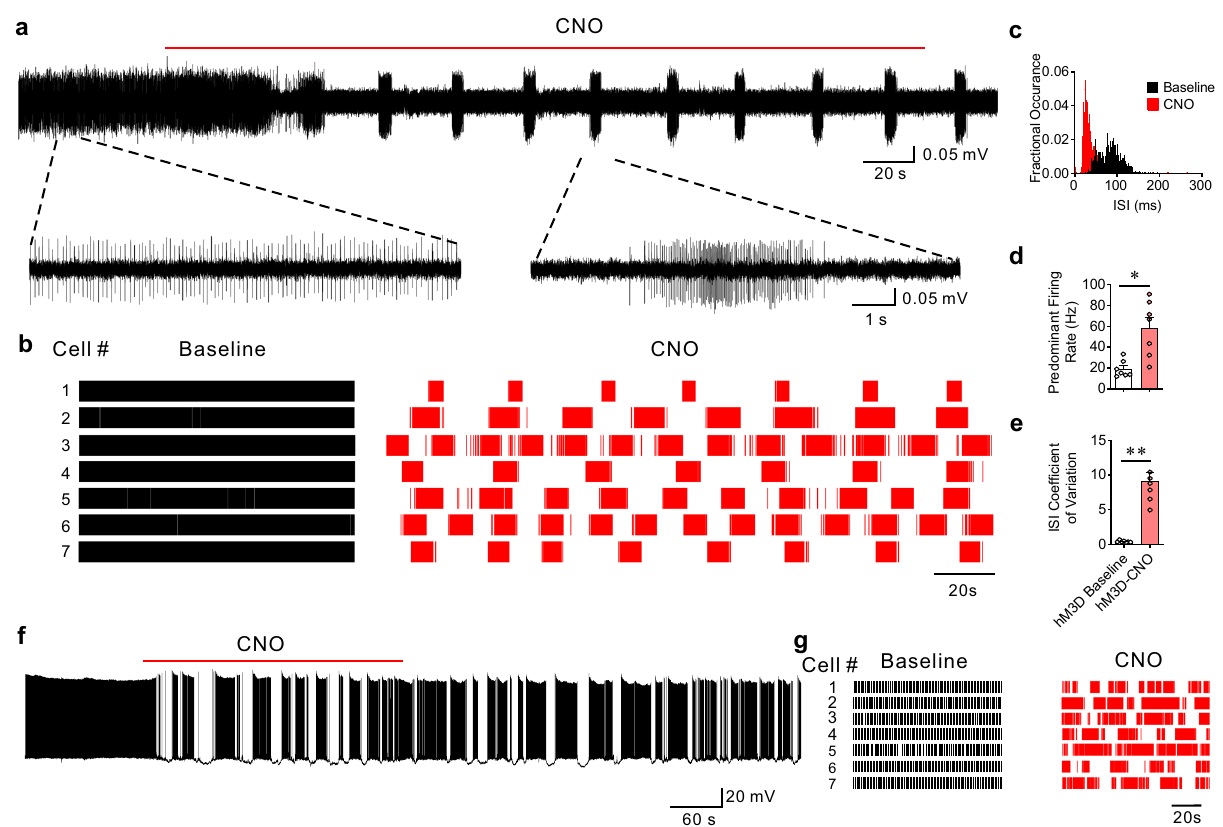
Fig. 5 Burst fi ring in PV interneurons transforms BLA neural activity. a A representative recording showing that chemogenetic activation of PV interneurons switches the fi ring pattern of PV cells from tonic to phasic. Below: Traces were expanded to show the tonic fi ring of the baseline and burst fi ring after CNO application. b Raster plots of spiking activity in recordings from 7 PV interneurons (from 3 mice) that show the transformation of tonic spiking to phasic spiking by CNO. c Representative interspike interval (ISI) histogram of the cell shown in a . d , e Gq activation increased the predominant fi ring rate ( d ) and the ISI coef fi cient of variation ( e ) in the BLA PV interneurons (mean ± SEM, n = 7 cells from three mice, paired t -tests (two-tailed): predominant fi ring rate, CNO vs. baseline, p = 0.013; ISI coef fi cient of variation, CNO vs. baseline, p = 0.0006, * p < 0.05, ** p < 0.01). f A representative current-clamp recording from a principal neuron showing that Gq activation in PV cells transforms the fi ring pattern of a BLA principal neuron from tonic to phasic. g Raster plots of spiking activity in recordings from seven principal neurons (from 3 mice) that show the transformation of tonic spiking to phasic spiking by CNO. Source data are provided as a Source Data fi